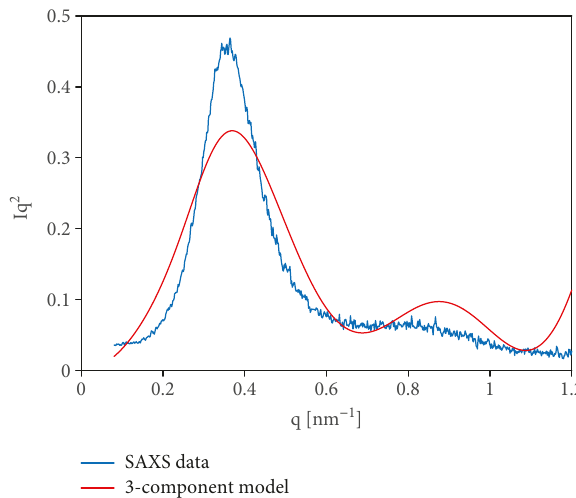
Figure 6: Representative result of the 3-component model fi t (SAXS data belongs to the Delrin_IM_110 ° C-MT